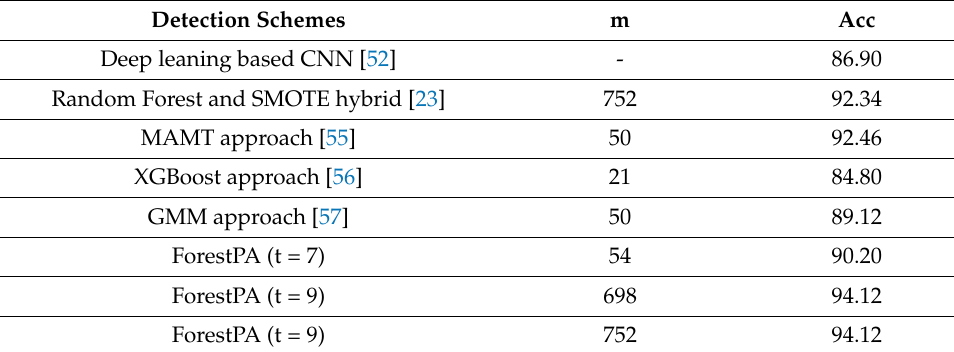
Table 11. Comparative analysis of the proposed ForestPA approach of Parkinson’s detection with other cutting-edge approaches of Istanbul acoustic